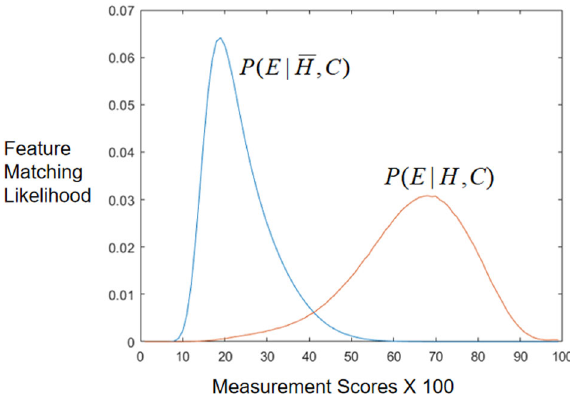
Fig. 4 Feature-matching measurements. The measurements of feature- matching distribute in a range.